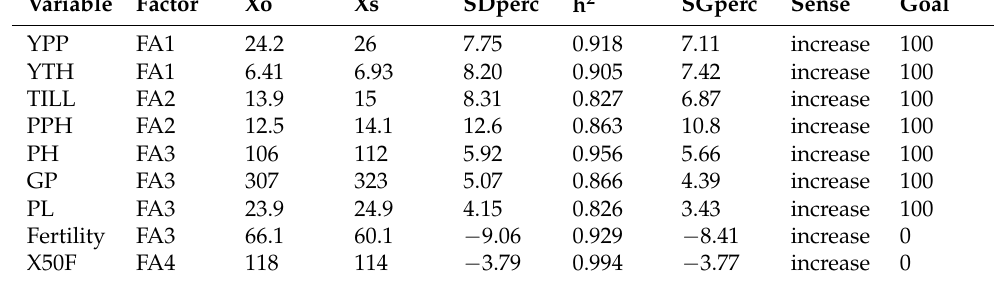
Table 9. Original value (Xo), selected value (Xs), selection differential in percentage (SDperc), heri- tability (h 2 ), and selection gain in percent (SGperc) for the MGIDI in 34 rice genotypes in Barishal. Variable Factor